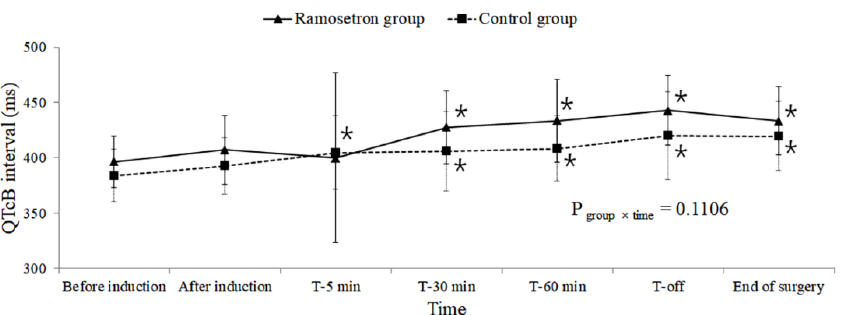
Figure 2. Changes in QT interval during robot-assisted laparoscopic prostatectomy. Values are presented as mean ± standard deviation. T-5 min, 30 min, 60 min: 5, 30, and 60 min after assuming the steep Trendelenburg position with CO 2 pneumoperitoneum; T-off: Immediately after assuming a supine position with CO 2 desufflation. * Bonferroni-corrected p < 0.05 compared with the value before induction within each group.